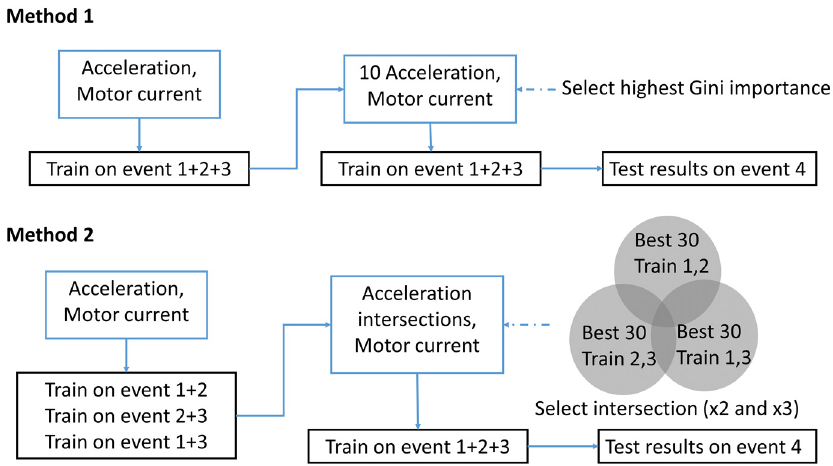
Figure 12. 4-Fold cross-validation results for trials 1 to 4 with T RUL = 70 days, trained on A/C dataset using Method 1 and ERTs regressor.